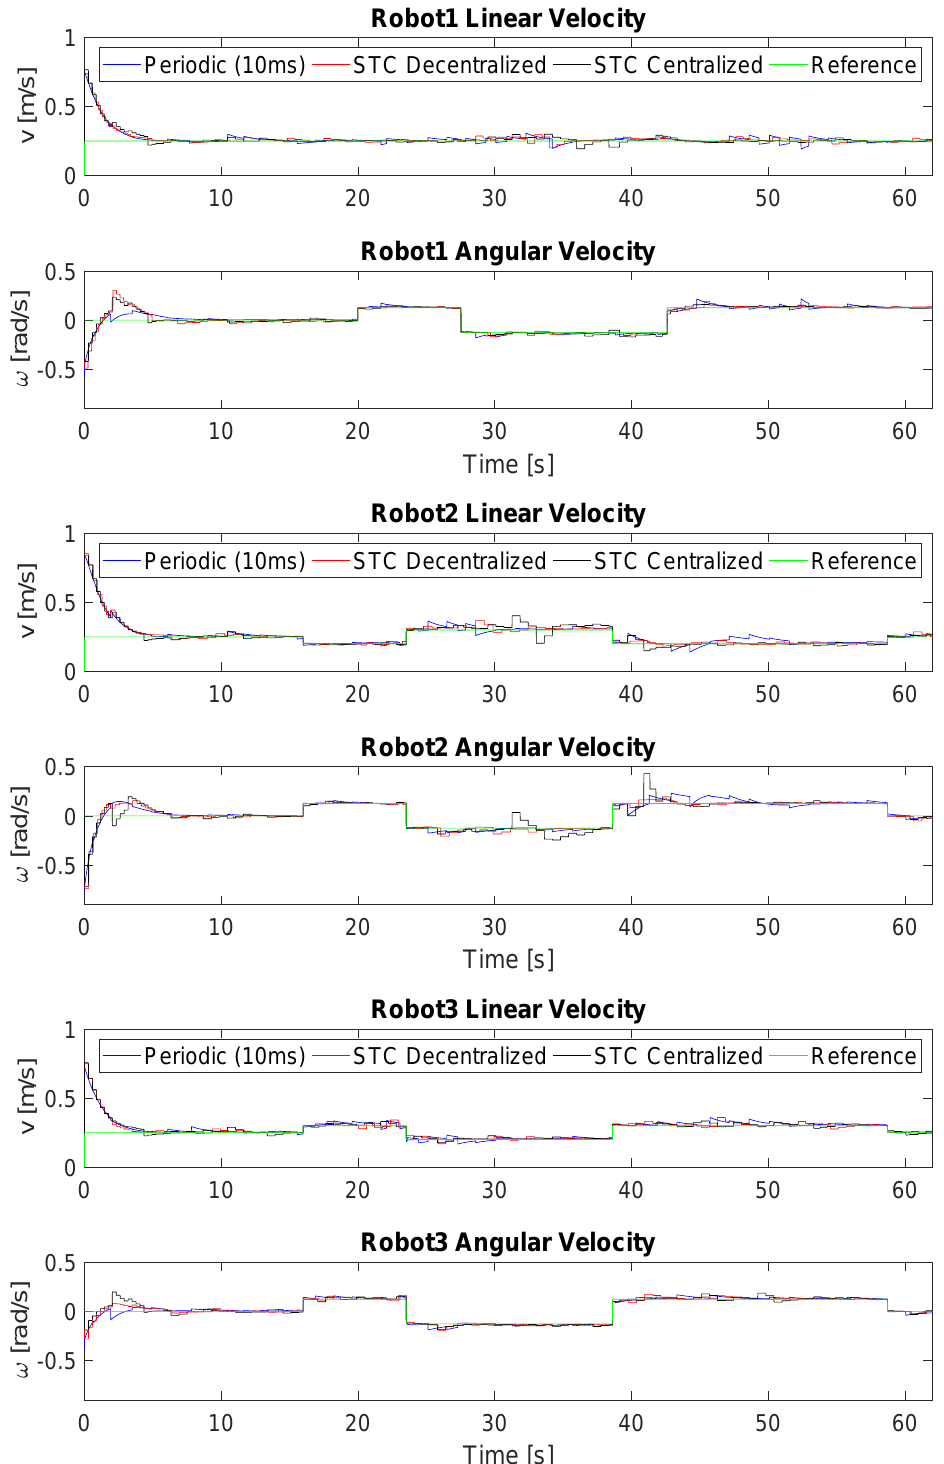
Figure 11. Linear and angular velocity references and commands of the formation. Robot 1 is represented in the top figure, Robot 2 in the middle one and Robot 3 in the bottom. The velocity done by each robot is presented in blue for the periodic implementation, in red for the STC with decentralized triggering (27) and in black for the centralized triggering (26). The velocity reference of each unit is presented in